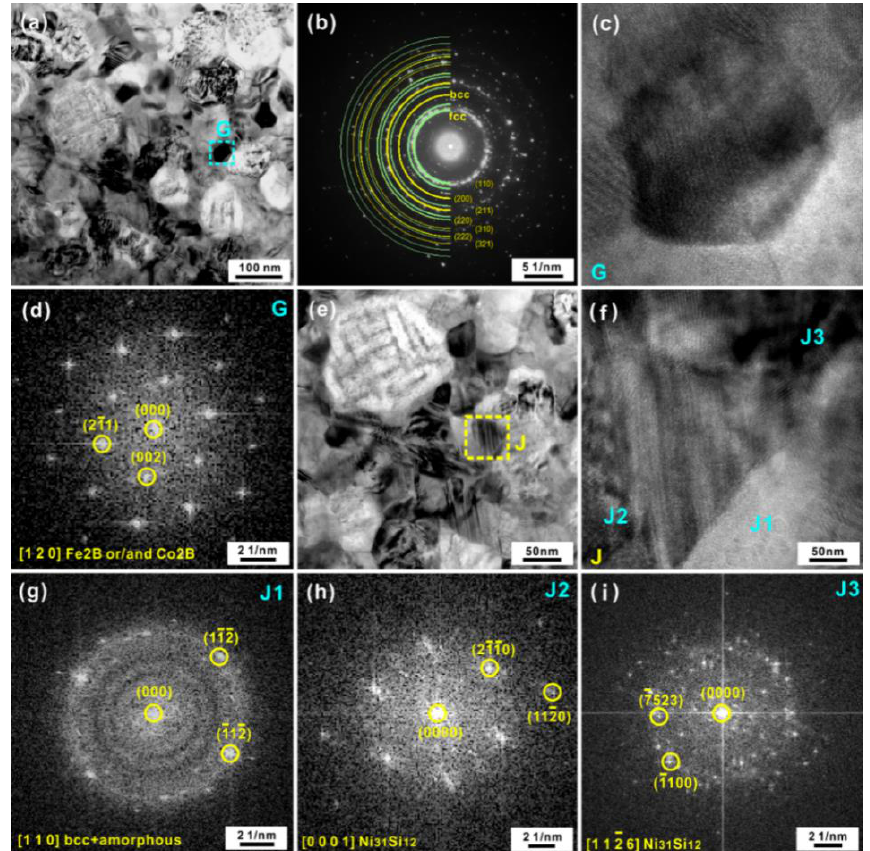
Figure 3. ( a ) Characteristic bright-field TEM image of other regions of the AR samples heated to 852 K and ( b ) the corresponding SAED pattern, ( c ) the HRTEM image of the region G and ( d ) the corresponding FFT patterns, ( e ) the local enlarged image of the region in Figure 2b, ( f ) the HRTEM image of the region J, the FFT patterns of the domains ( g ) J1, ( h ) J2, and ( i ) J3.